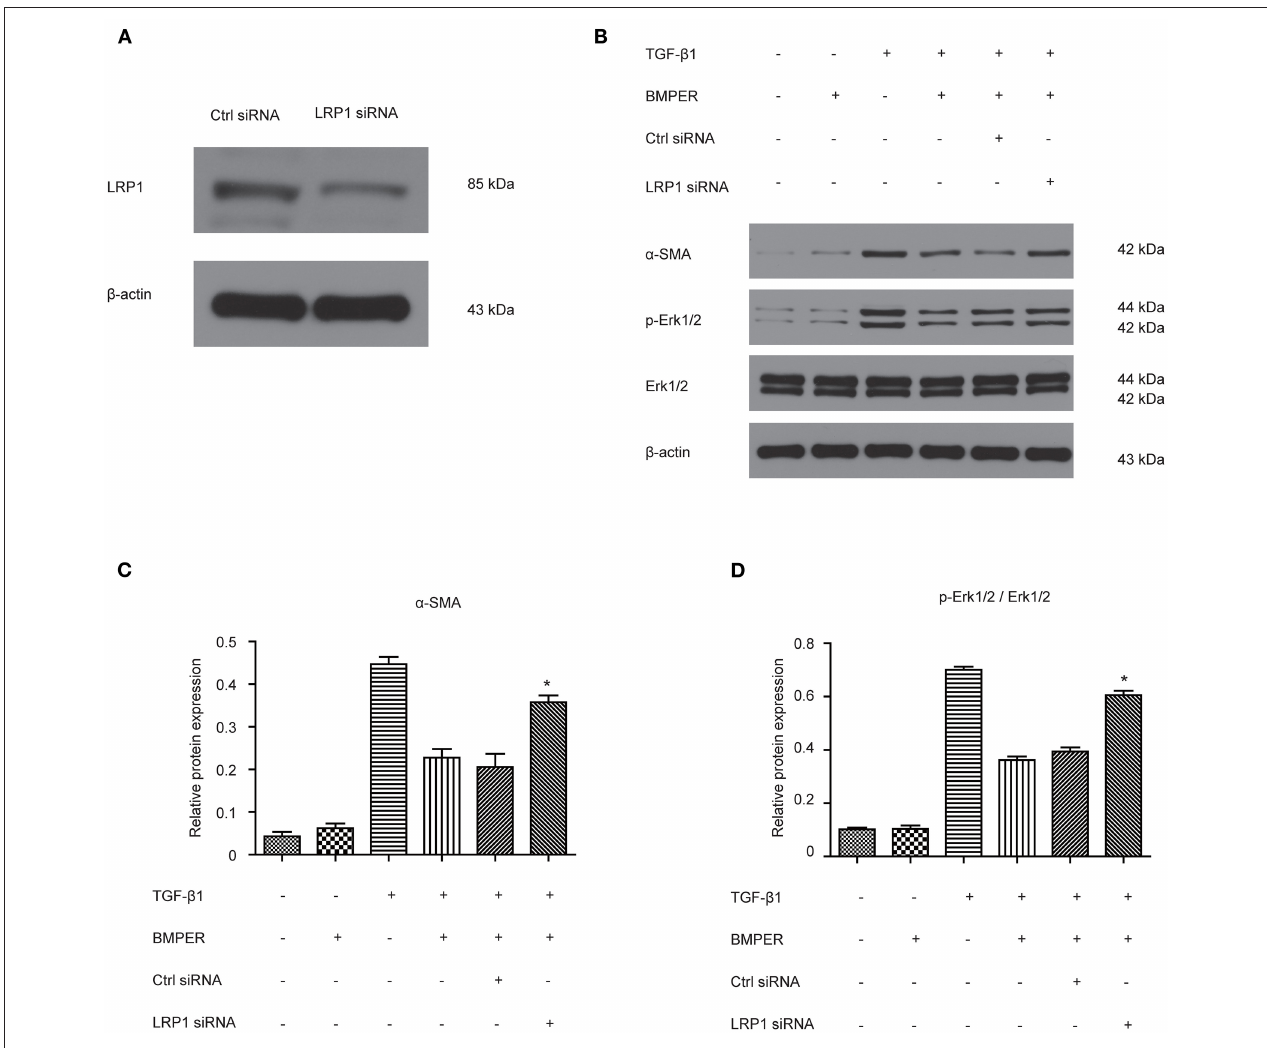
FIGURE 6 | The inhibitory effect of BMPER on Erk1/2 phosphorylation was dependent of LRP1 in NRK-49F cells. The effect of LRP1 siRNA transfection on LRP1 protein expression (A) Erk1/2, p- Erk1/2 were measured by Western blot 15min after NRK-49F cells with different treatments (B) . The relative protein expression for α -SMA and p-Erk1/2/Erk1/2 in NRK-49F cells was displayed (C,D) . Values are the means ± SEM ( n = 3). * p < 0.05 vs. cells treated with TGF- β 1 plus